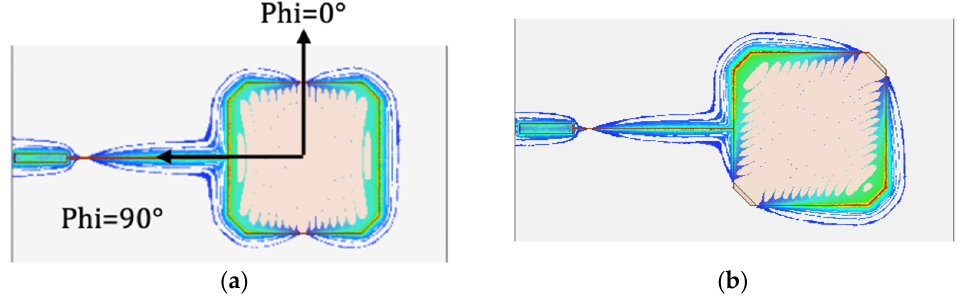
Figure 3. A simulated EM field. ( a ) Horizontal Linear Polarization. ( b ) 45° Linear Polarization.